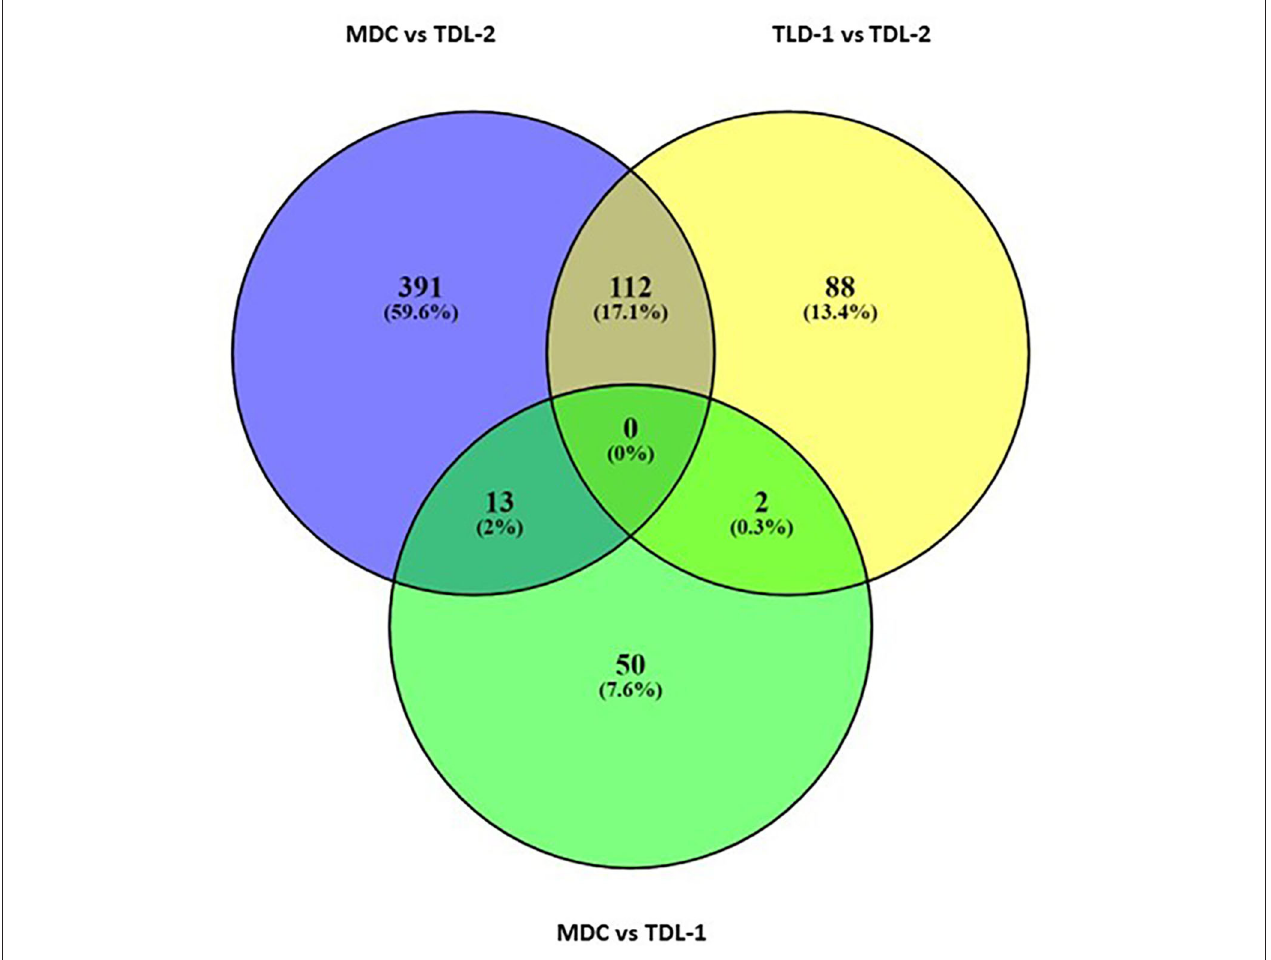
FIGURE 5 | Venn diagram of divergent SNPs (with an F ST threshold to > 0.25) among the three populations defined with cluster analysis. The numbers in parentheses show percentages of divergent SNPs out of the total number. MDC, TDL-1, and TDL-2 indicate modern durum cultivars, Tunisian durum landraces groups 1 and group 2,